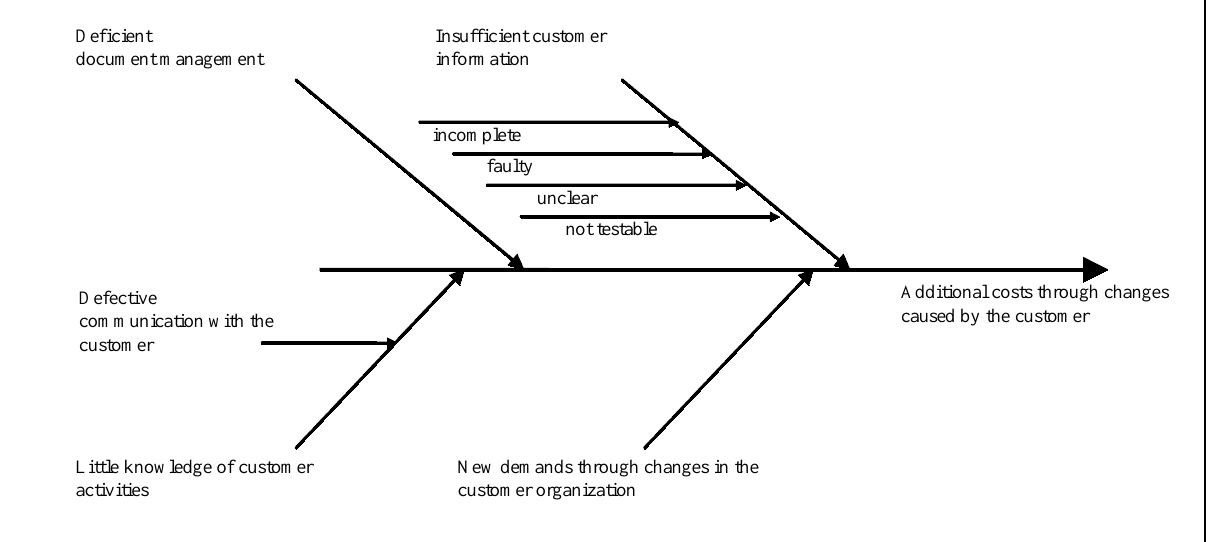
Fig 2. Ishikawa Diagram for altered customer